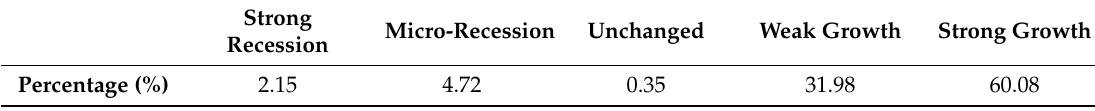
Table 3. Percentages of forest land area with different growth trend.